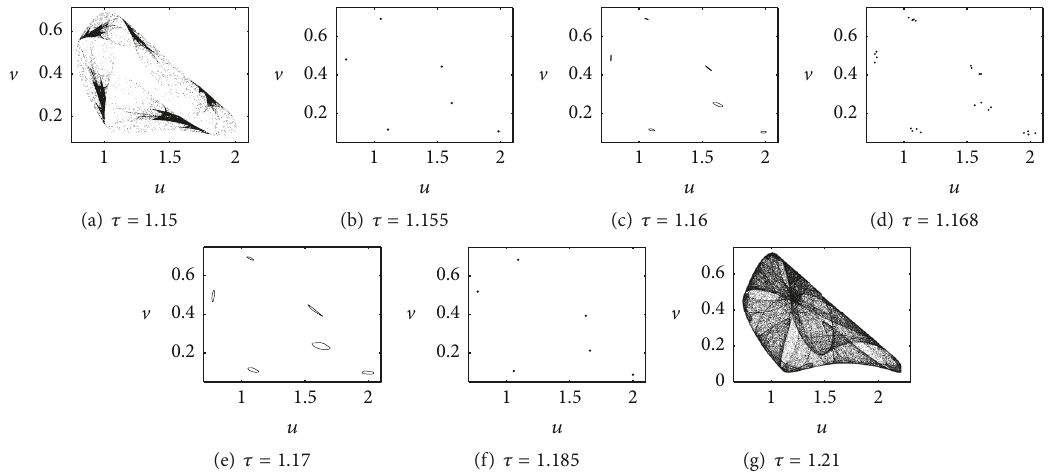
Figure 8: Phase portraits for various values of 𝜏 corresponding to Figure 7(a).